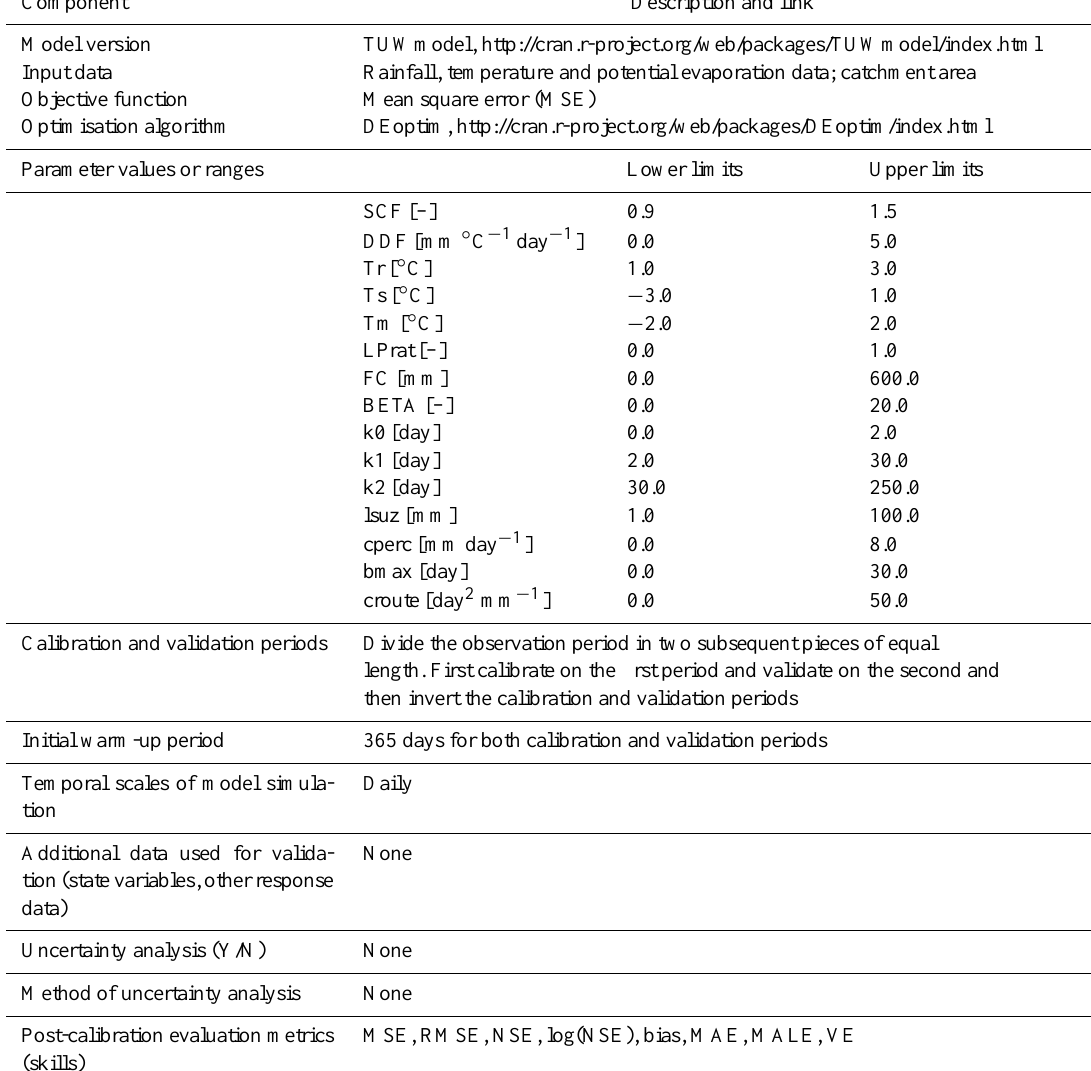
Table 2. Main settings of Protocol 1 of the first collaborative experiment of the SWITCH-ON Virtual Water-Science Laboratory.